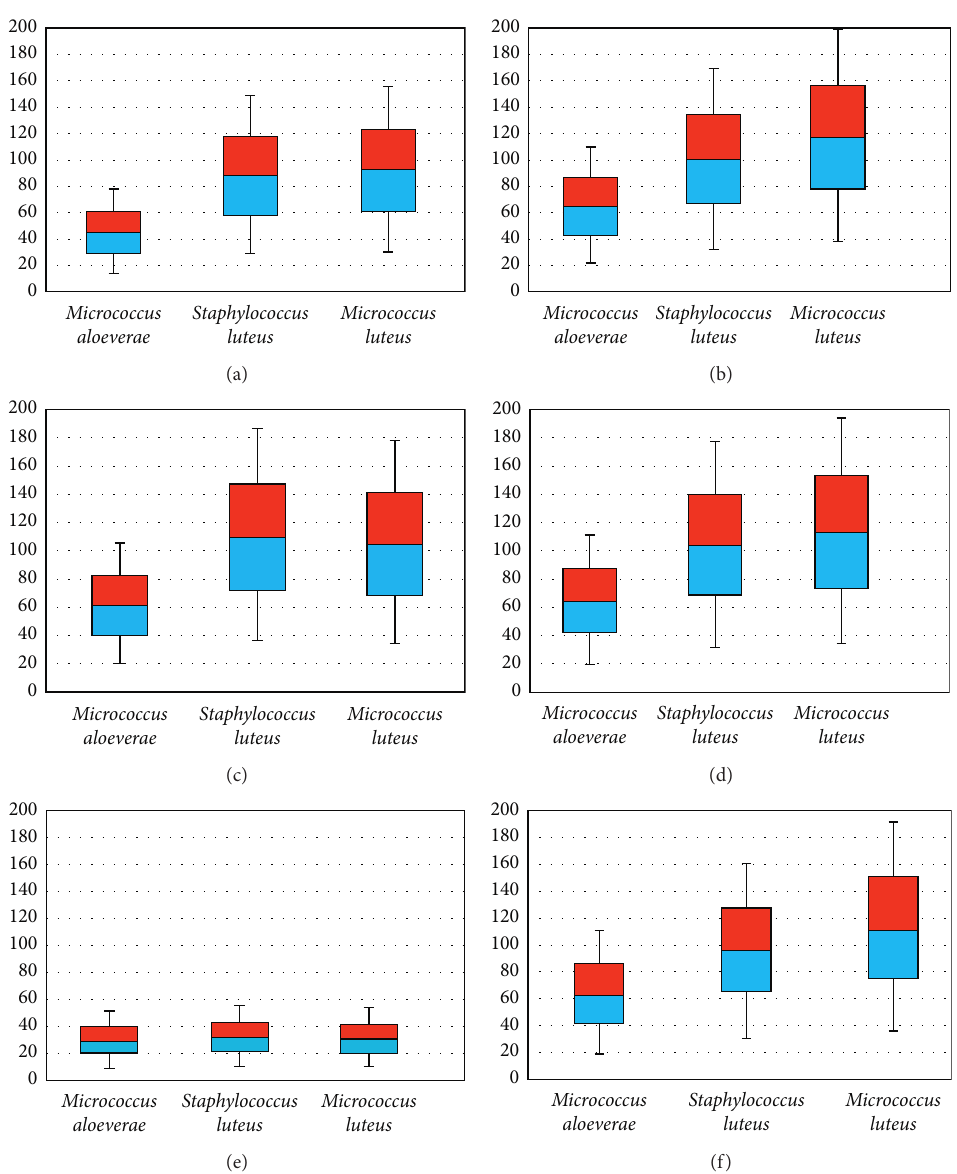
Figure 4: Box and Whisker plot (min/max, lower/upper quartiles and median) showing overall disinfection efficacy of various disinfectants against streptococci/micrococci groups of bacteria. Y axis shows the average diameter of inhibition zones. Here, (a) Lysol; (b) Quatovet; (c) Savlon; (d) Virocid; (e) Alcohol; (f) Virkon S. Table 2: Minimum inhibitory concentration (MIC) values of the disinfectants as determined for S. lentus and Micrococcus spp. by broth dilution. Disinfectants Savlon (%) Virocid (%) Lysol (%) Virkon S (%) Quatovet (%) Bacterial group Staphylococcus lentus 20 10 30 10 10 Micrococcus luteus 30 10 40 20 10 Micrococcus aloeverae 40 10 50 60